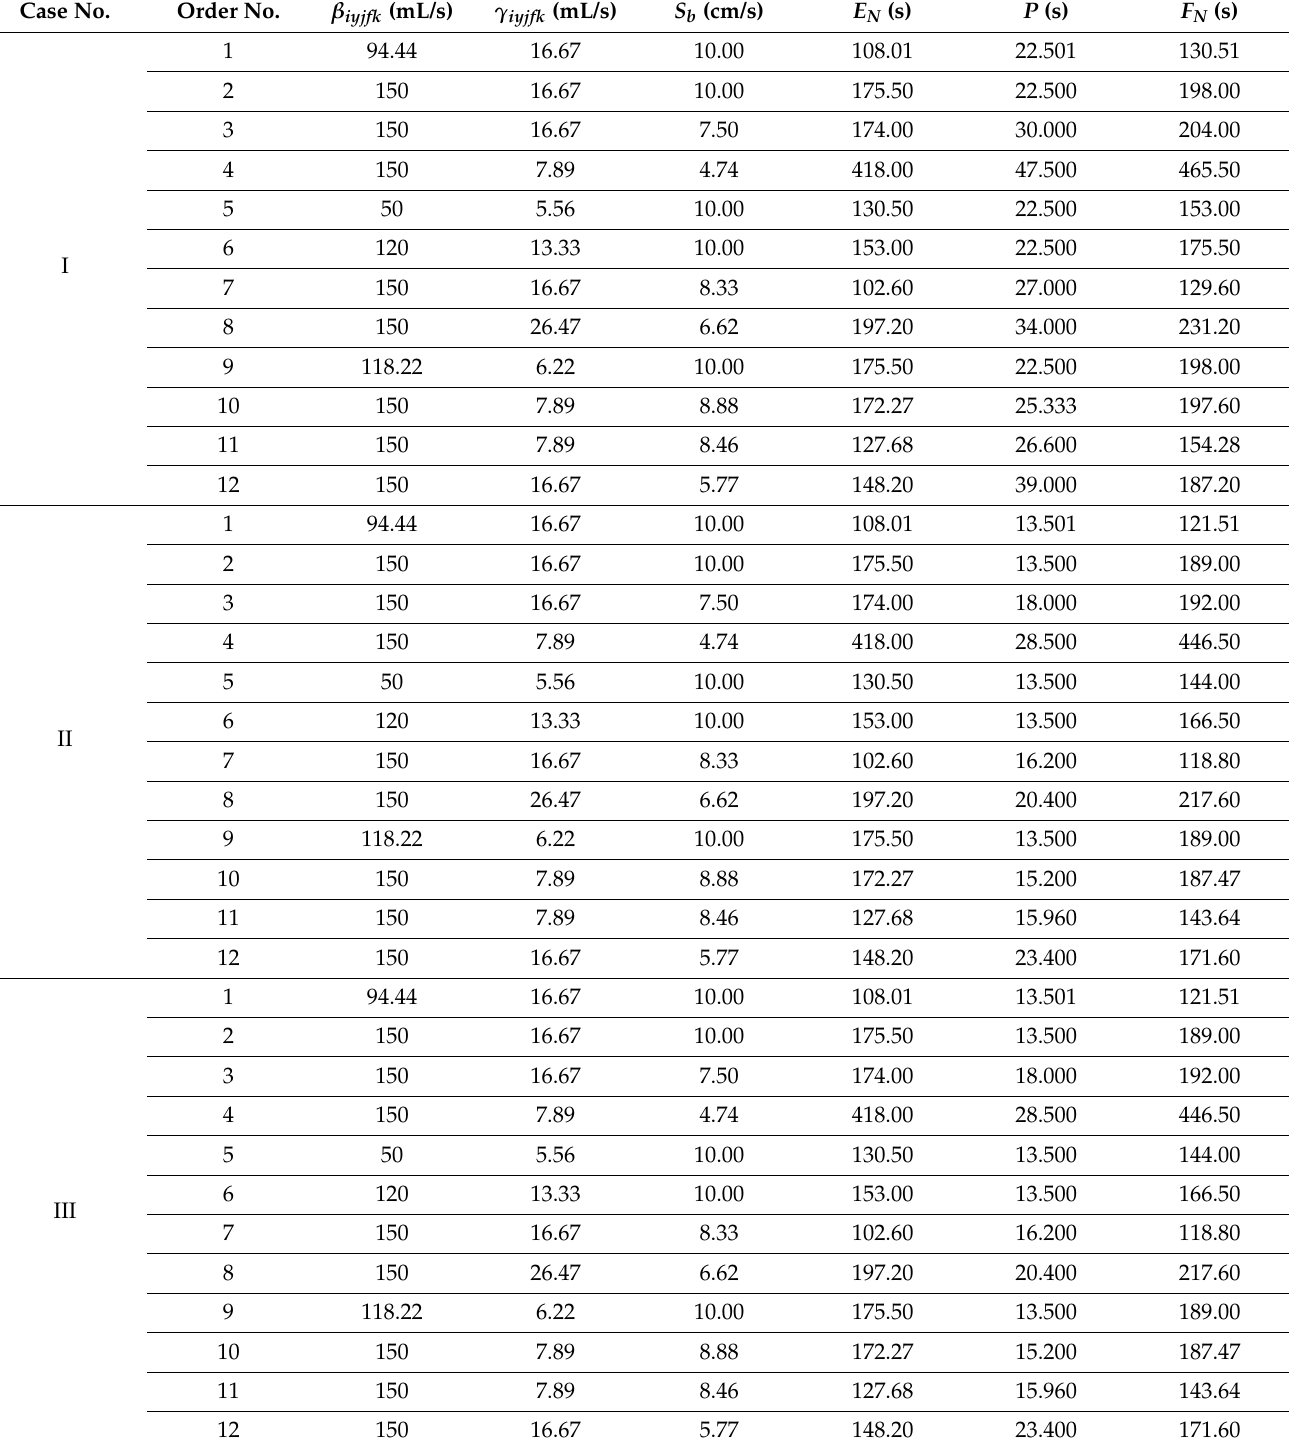
Table 3. Optimal solutions in three cases for the same set of customer